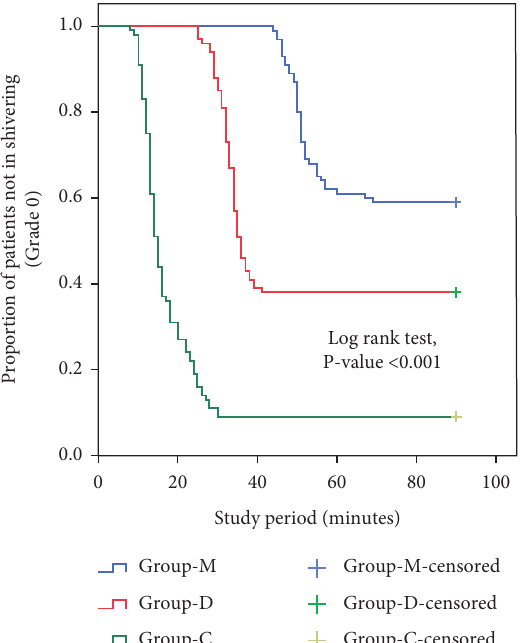
Figure 5: Proportions of patients not in shivering (Grade 0) represented on the Kaplan Meier plot.